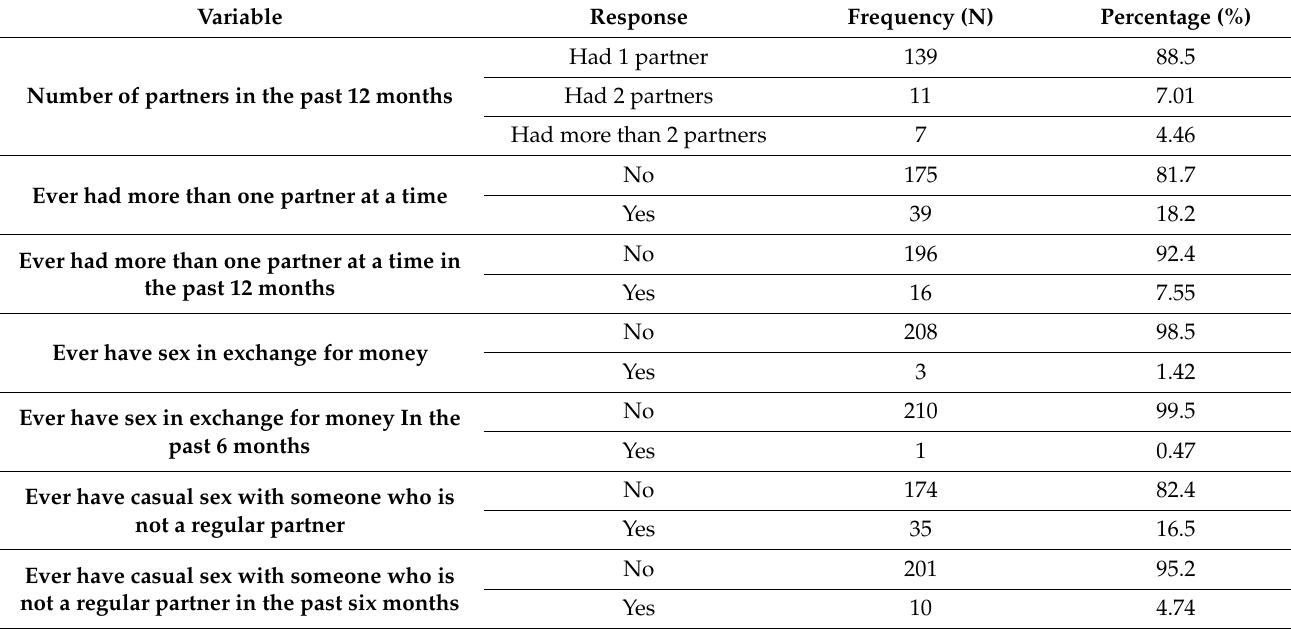
Table 4. Sexual partners (n = 201) of participants.